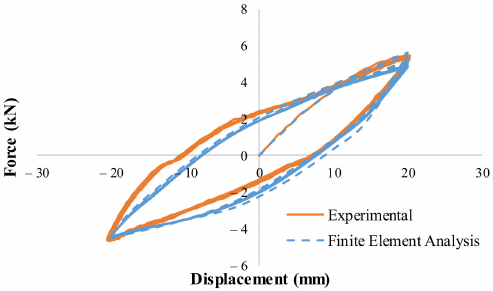
Figure 5. Force–displacement curves of press-to-connect elbow system.